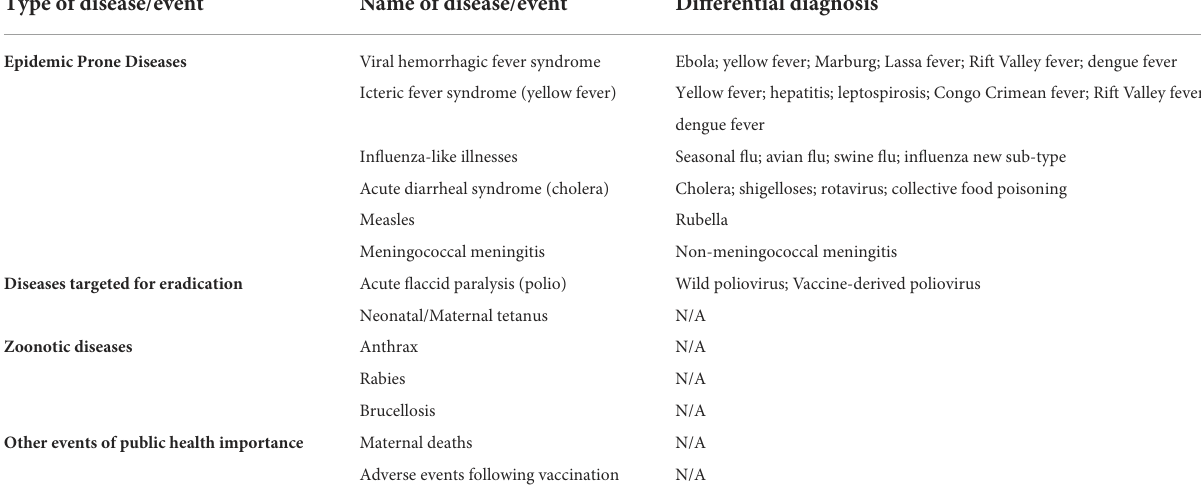
TABLE 2 Guinea-specific IDSR priority diseases and events with differential diagnosis